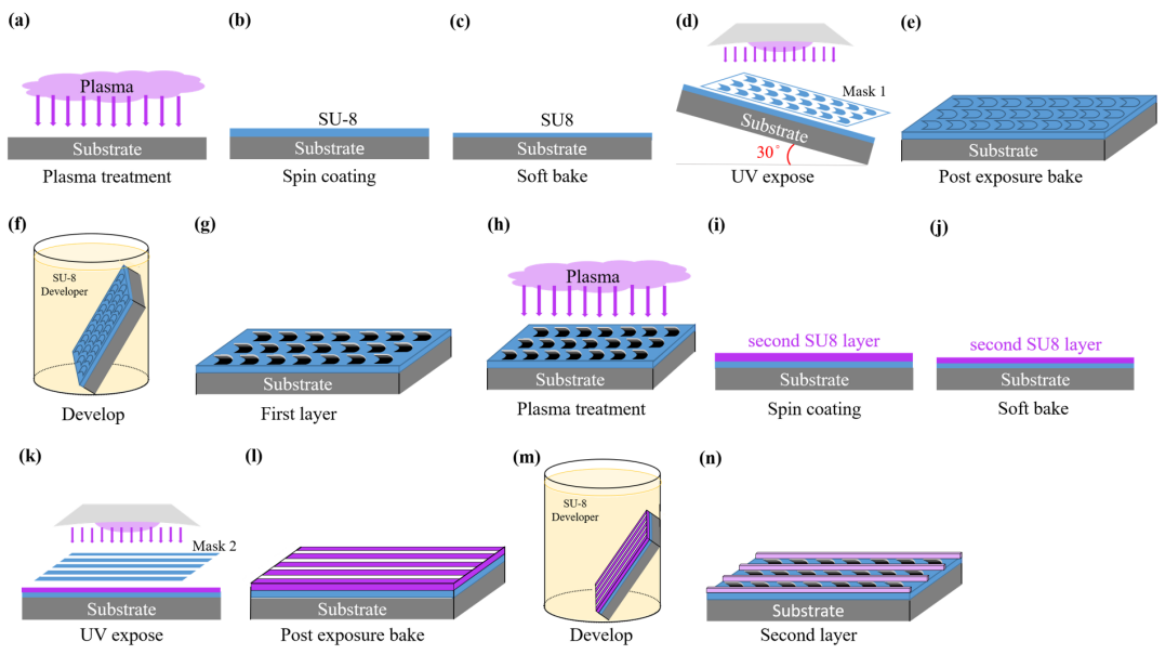
Figure 1. Diagram of the photolithography process of a Nepenthes peristome-like structure. 2.2. Replica of a Nepenthes Peristome-like Structure by PDMS Polydimethylsiloxane (PDMS, Dow Corning ® Sylgard 184, part A) and a